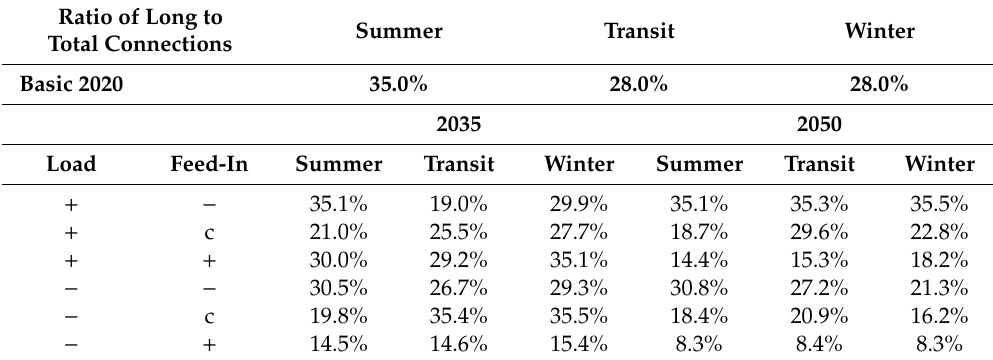
Table 11. RC t ratio of long-distance